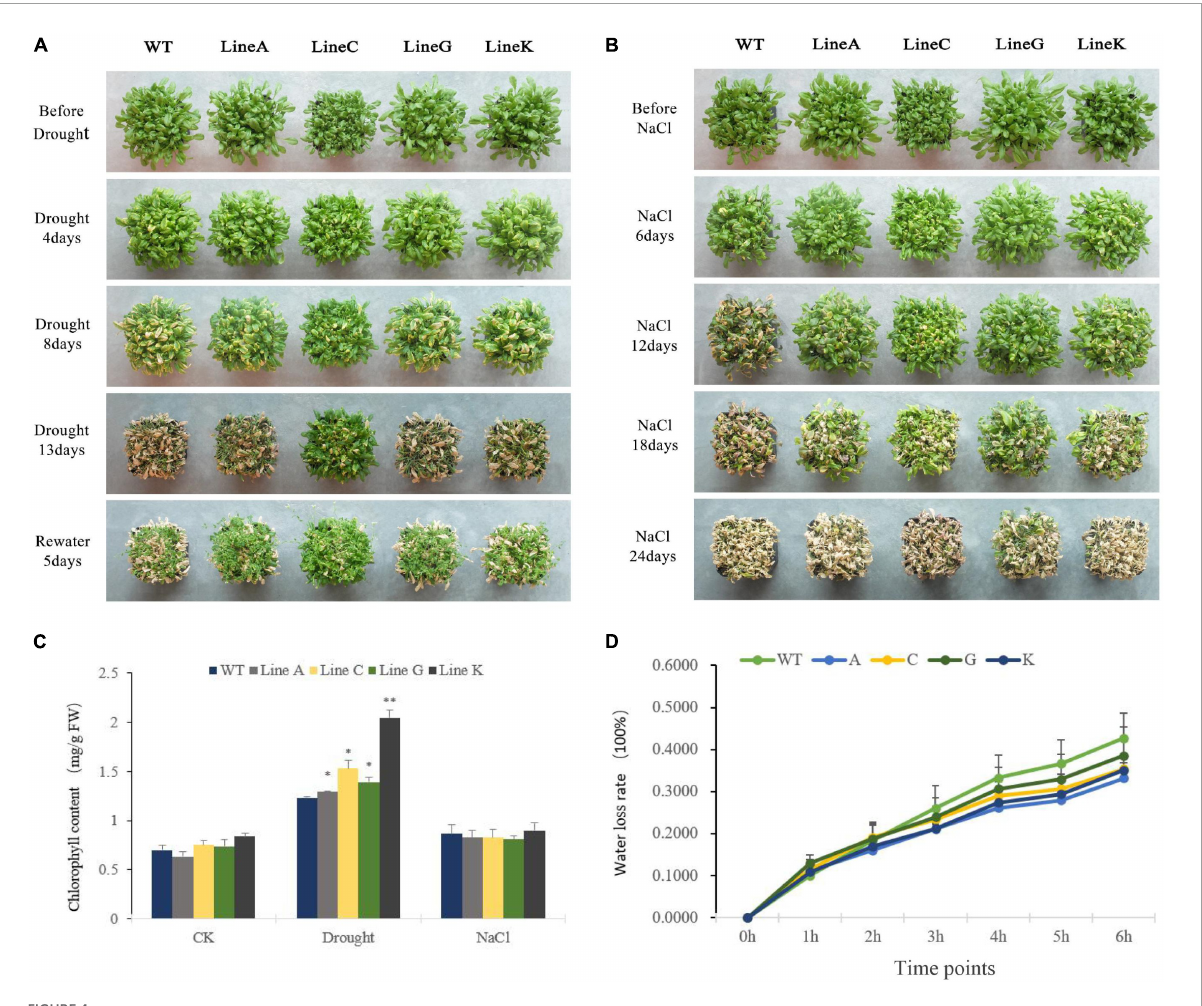
FIGURE4 Analysis of drought and salinity tolerance at the adult stage. (A,B) Showed the growth status of transgenic and WT plants during natural drought and salinity treatments (300 mM NaCl solution). (C) Chlorophyll content of WT and transgenic lines under different conditions. (D) Water loss rates of detached leaves measured at 25 ◦ C room temperature. Data are presented as mean and SD values of three independent experiments. Asterisks indicated significant difference ( ∗ P < 0.05, ∗∗ P < 0.01) comparing to